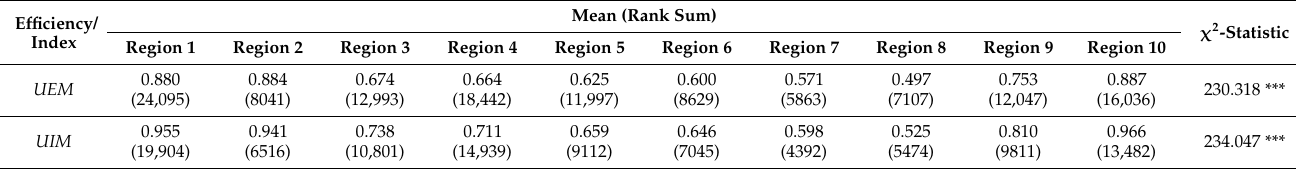
Table 11. Kruskal-Wallis Tests of States of EPA’s Ten Different